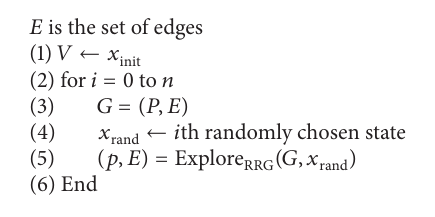
Table 1: Elements of